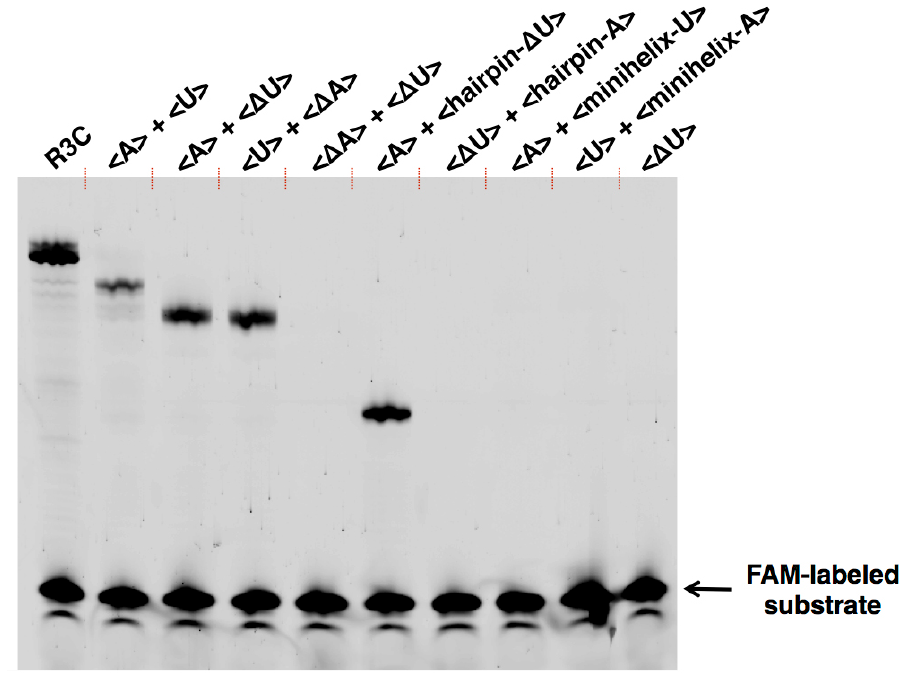
Figure 6. Ligation activities of the combinations of <A>, <U>, < ∆ A>, < ∆ U>, <hairpin-A>, <hairpin- ∆ U>, <minihelix-A>, and <minihelix-U>. The sequence of each RNA is described in Figures 1, 3, and 7. The volume of the reaction mixture was 15 μ L and the incubation was performed at 23 °C for 18.5 h. The solution was put into the same volume of 7 M urea and 0.08% ( w / v ) bromophenol blue and then applied to denaturing 12% polyacrylamide gel electrophoresis. The gel was visualized on Typhoon FLA 7000 (GE Healthcare Japan, Tokyo, Japan).